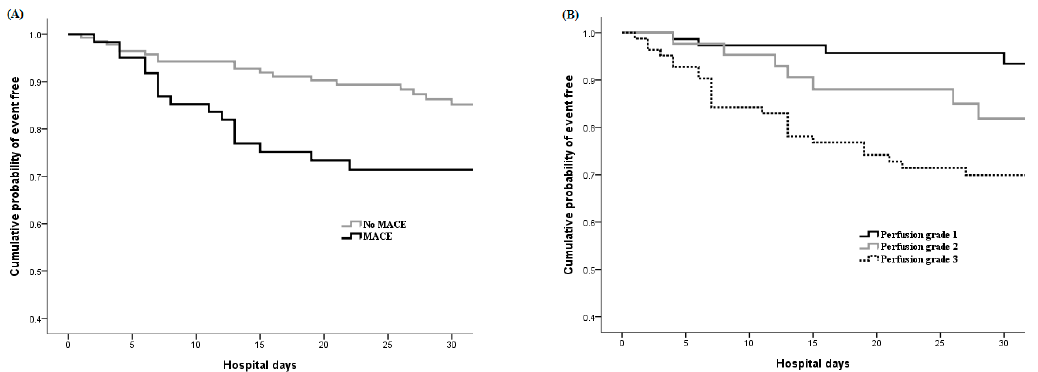
Figure 3. Kaplan-Meier curves of event free (major LEA or in-hospital mortality) in patients with SIRS stratified by ( A ) the association with MACE history and ( B ) the perfusion wound score.